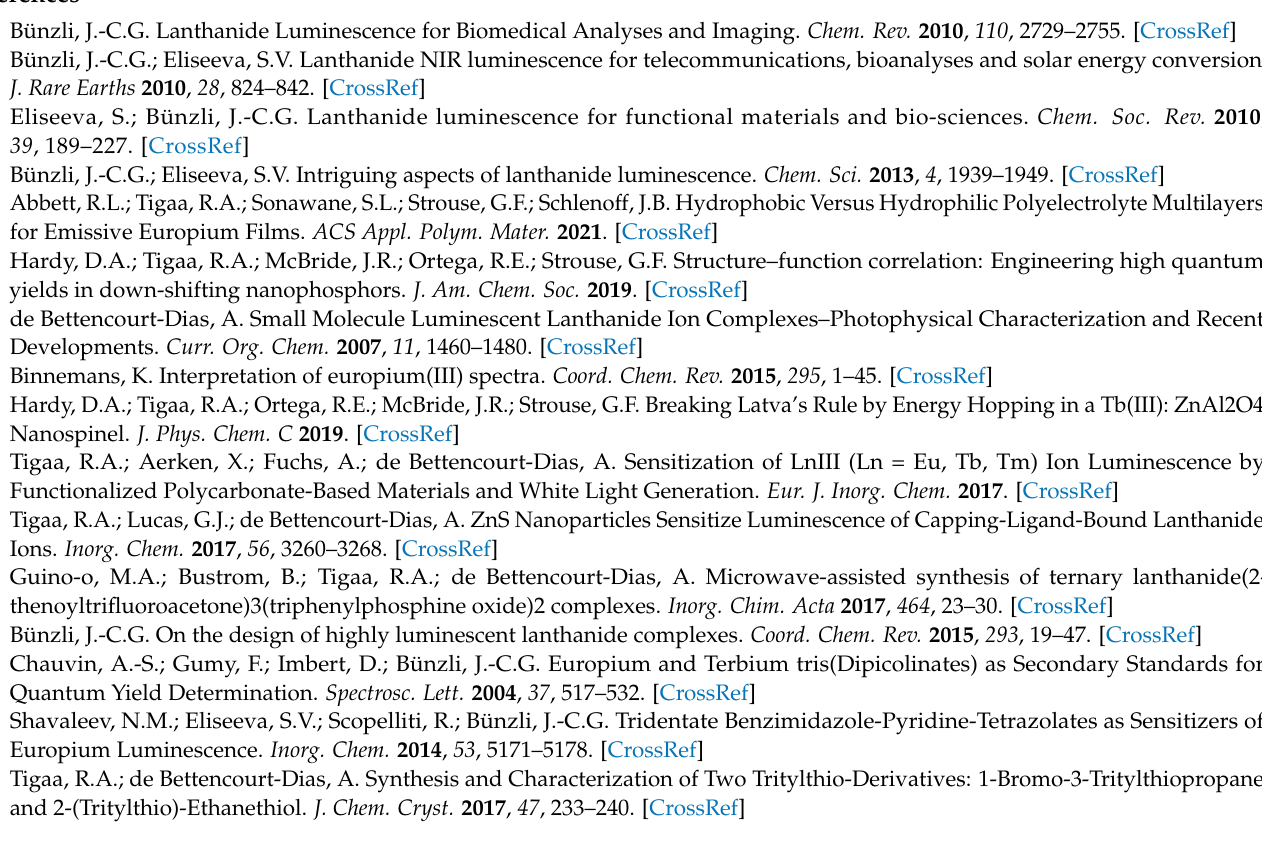
crystal X-ray data; Figure S5: UV–Vis absorption spectra; Figure S6: ligand excited singlet and triplet energy levels; Figure S7; Eu III and Tb III emission decay curves; Figure S8: Ce III emission decay curve. Crystallographic data for BimOEt 3 have been deposited with the Cambridge Crystallographic Data Centre, CCDC No.